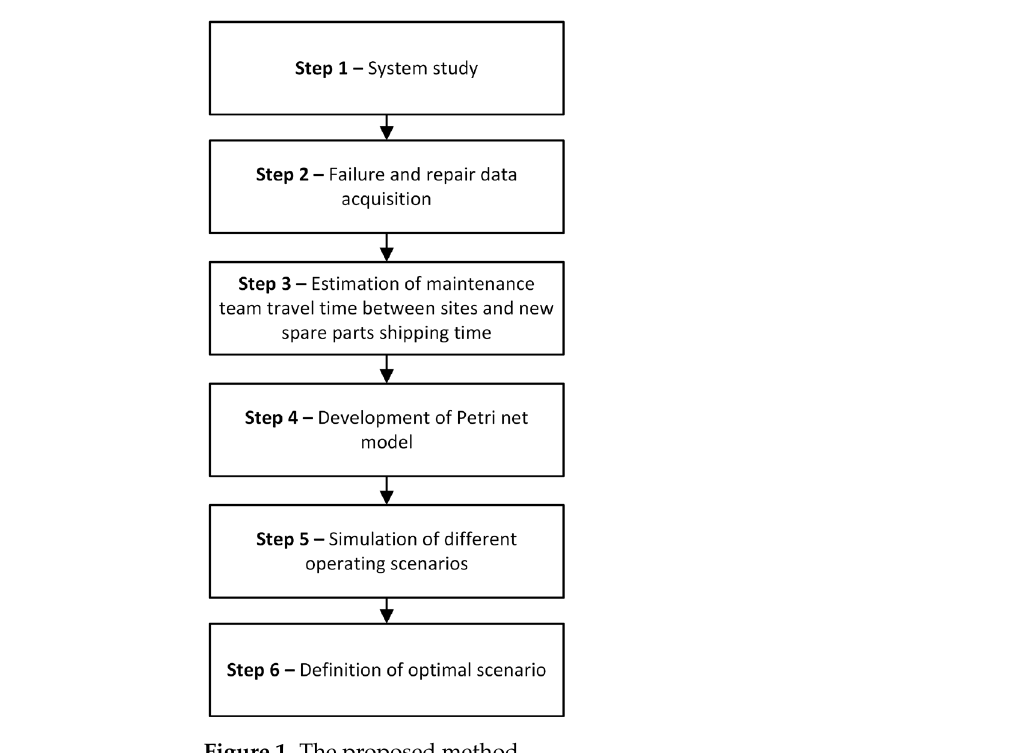
Figure 1. The proposed method.